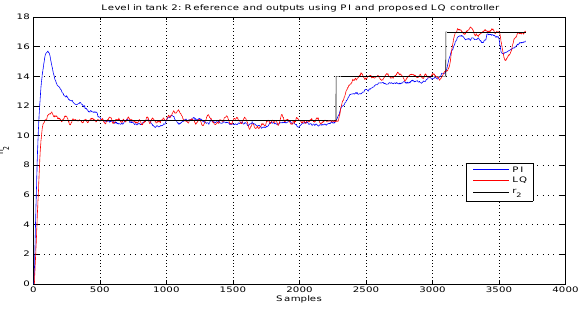
Figure 9: Quadruple tank process. Level in tank two. Illustrating the reference and the outputs from the process controlled by two single loop PI controllers, and the proposed LQ optimal controller with integral action. The LQ con- troller where constructed by using the DSR method for system identification. The DSR model was used to identify a Kalman filter for the system. The states were estimated with this Kalman filter and the determinis- tic part of the model was used to design the